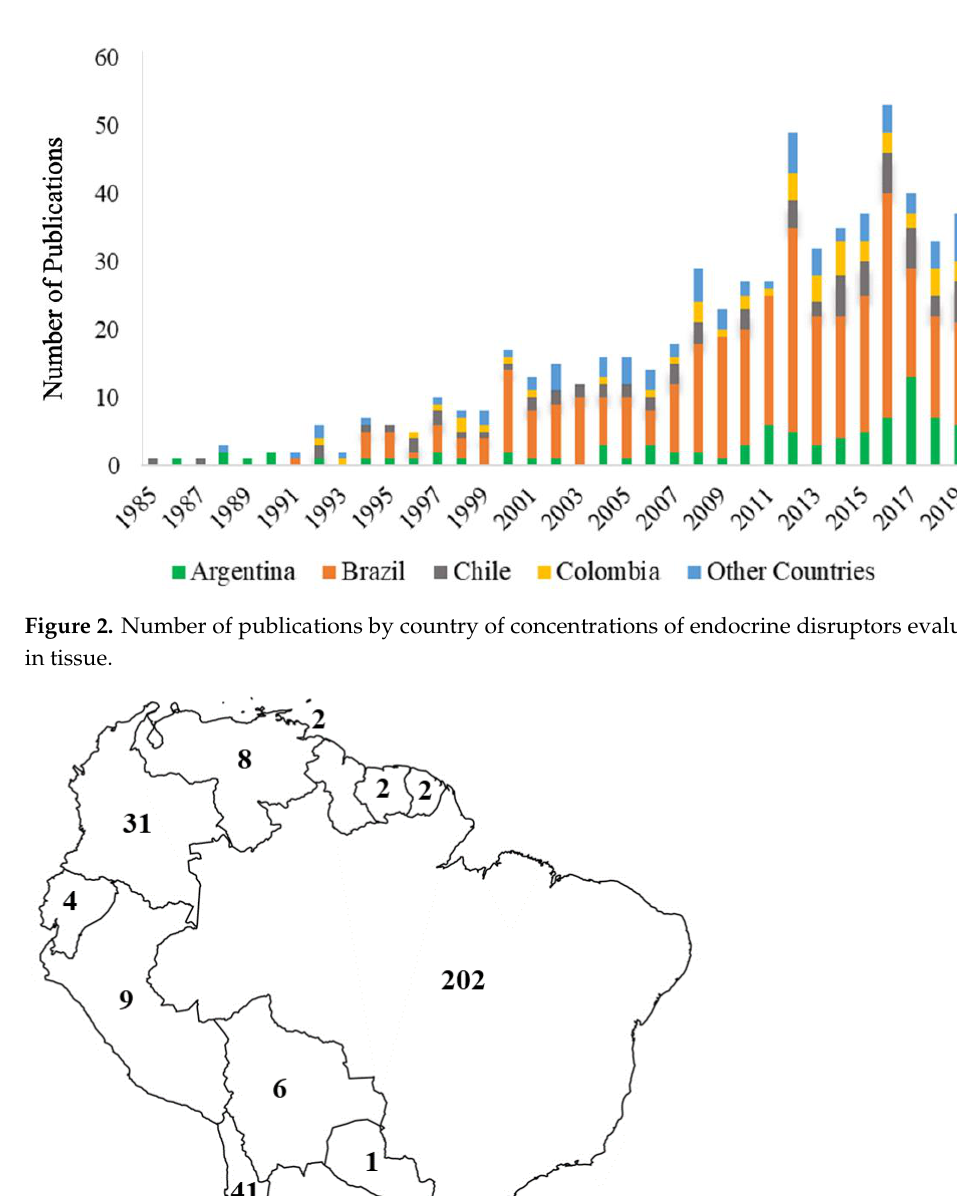
Figure 3. Number of papers in the last ten years in South America.